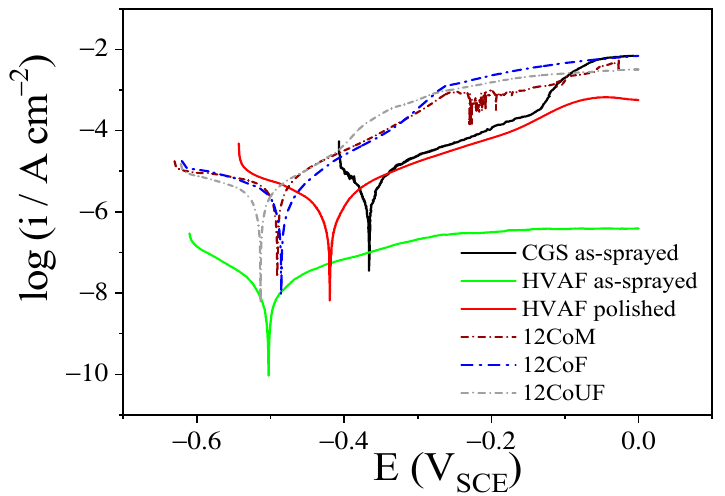
Figure 7. Potentiodynamic polarization curves for as-sprayed coatings and polished samples obtained in aerated and unstirred 3.56 wt% NaCl solution at 0.167 mV/s and 25 °C.